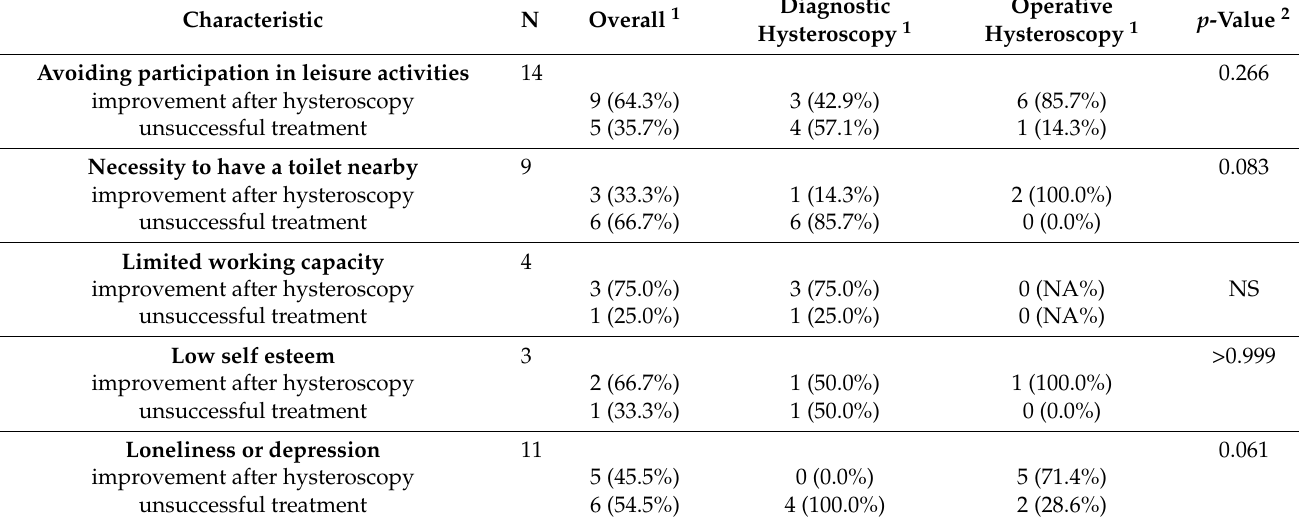
Table 3. The diagnostic vs. operative hysteroscopy and their influence on the psychological and environmental